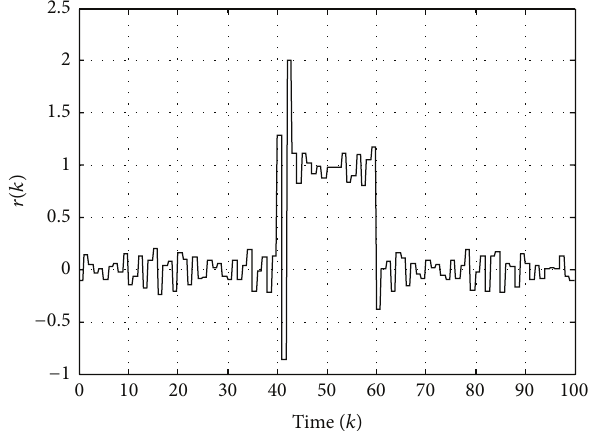
Figure 8: Residual signal 𝑟(𝑘) when 𝜌 = 0.9 and 𝐷 𝑓 (𝑘) = 0 .